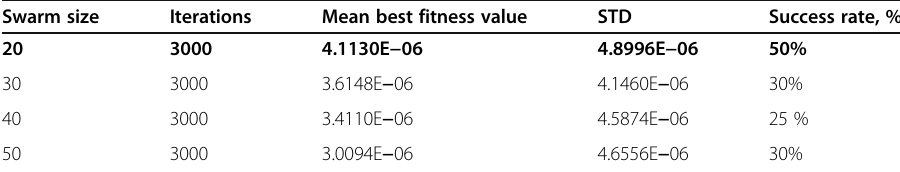
Table 3 Effect of swarm size change on QPSO-RBFNN performance Swarm